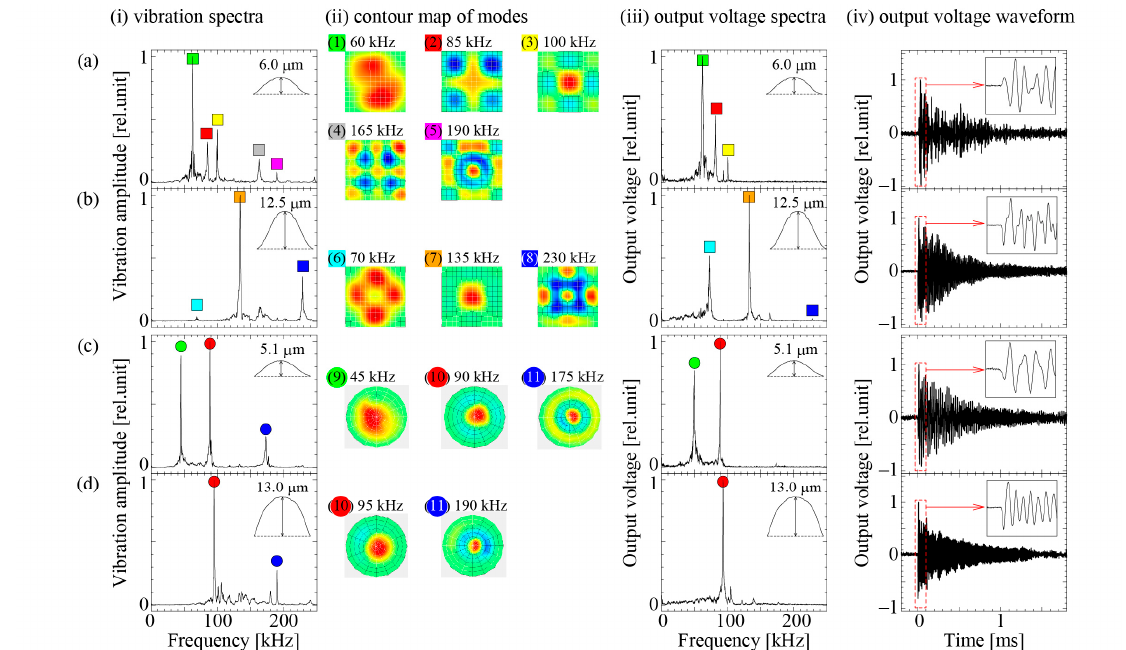
Figure 3. Pulse responses of the sensors on buckled diaphragms; ( a ) square, 6.0 µm, ( b ) square, 12.5 µm, ( c ) circular, 5.1 µm, and ( d ) circular, 13.0 µm; ( i ) vibration spectra, ( ii ) contour maps of the